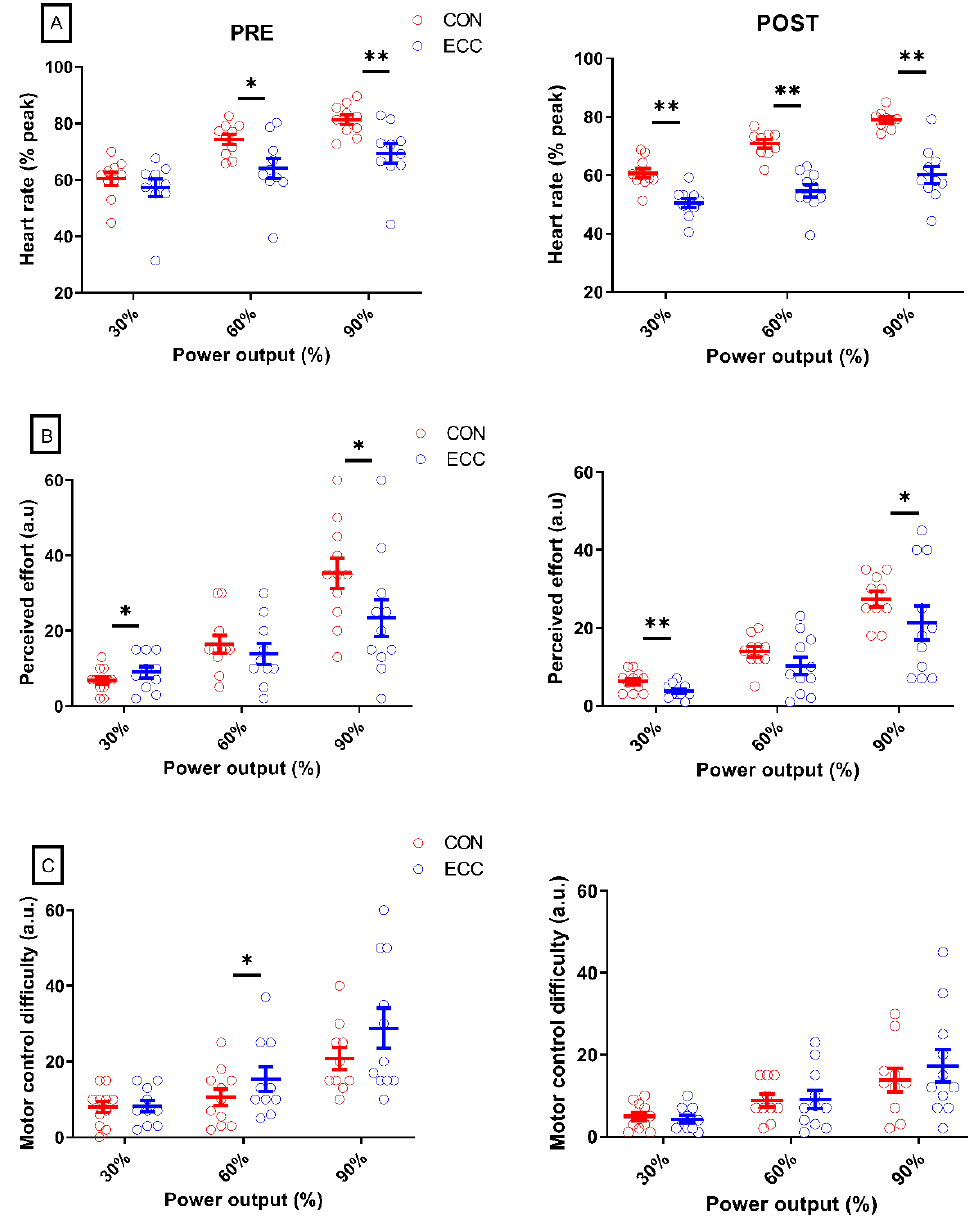
Figure 4. Heart rate and perceptual responses. Panel A represents the heart rate before (PRE) and after (POST) the four sessions of cycling. Panel B shows perceived e ff ort, and panel C the perceived di ffi culty to pedal at the requested cadence (“motor control di ffi culty”). Only three exercise intensities are displayed for sake of clarity. Di ff erence between CON and ECC cycling values at a given power output: * means p < 0.05; ** means p < 0.01. Error bars represent the standard